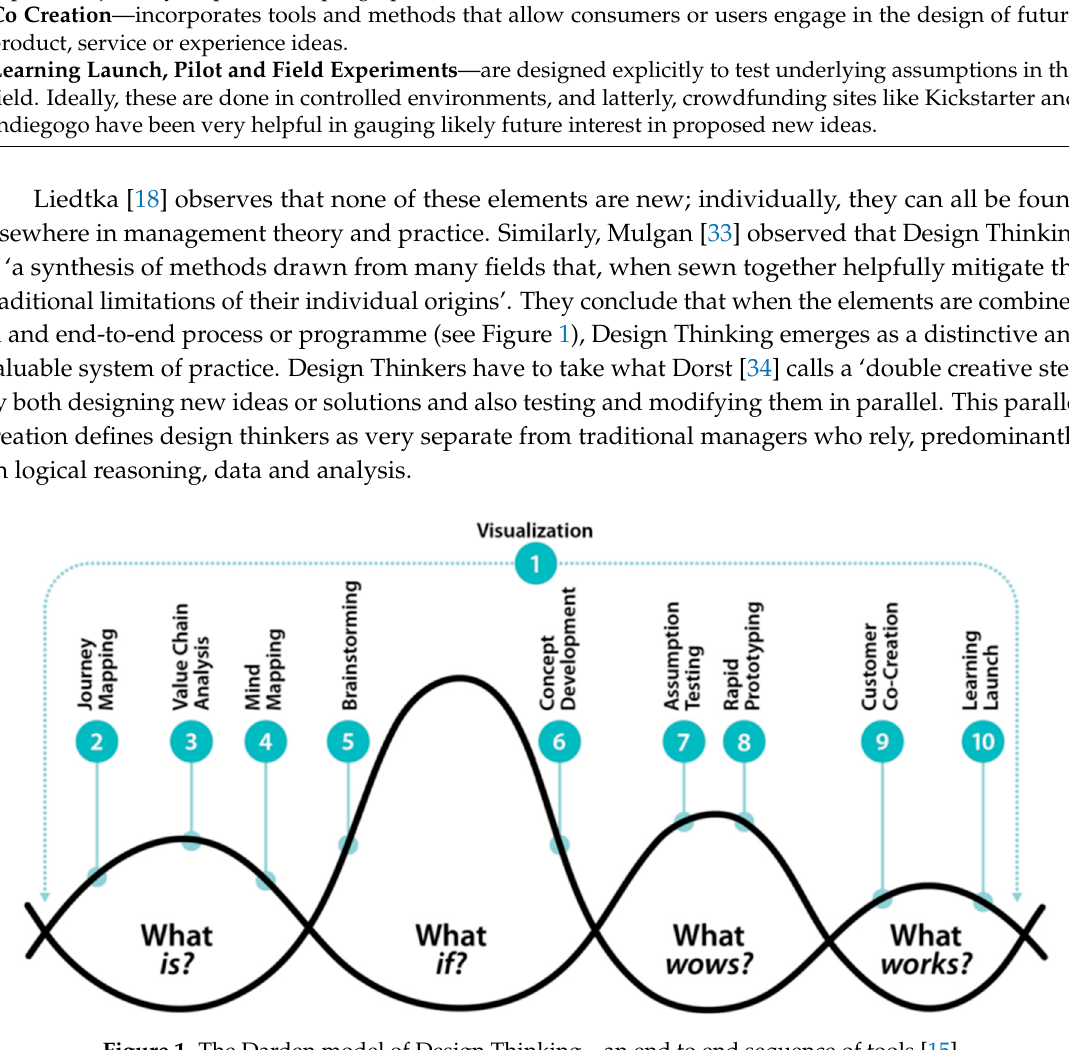
Figure 1. The Darden model of Design Thinking—an end to end sequence of tools [15].